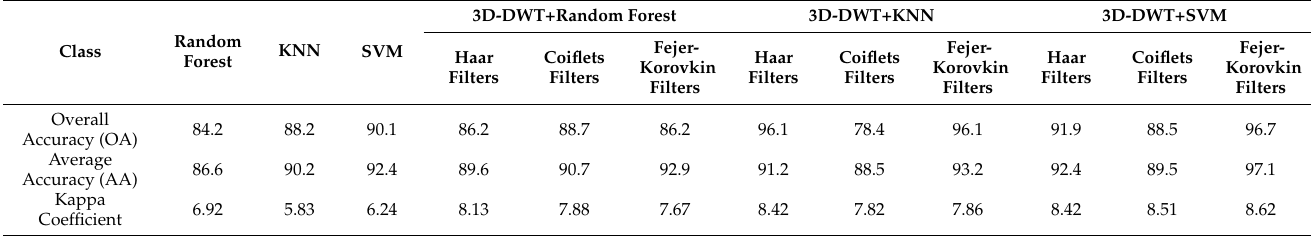
Table 6. OA, AA and kappa coefficient of entire class with different algorithms for Salinas Scene hyperspectral